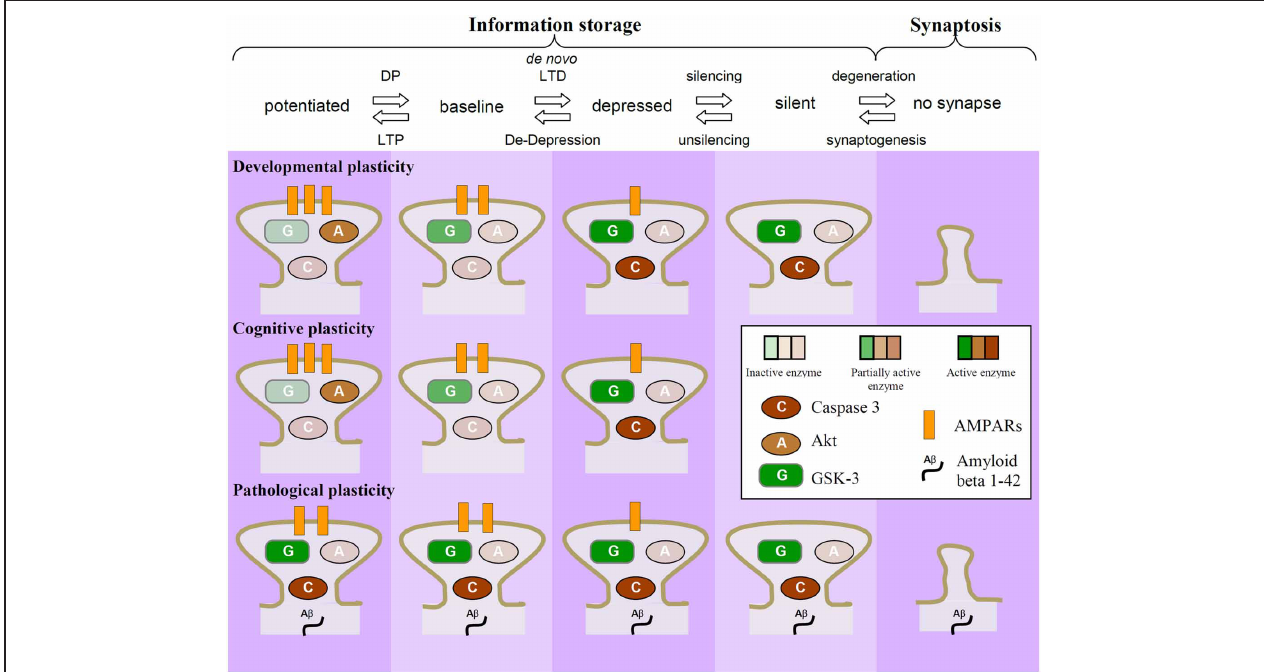
FIGURE 4 | Dysregulation of GSK-3 as a potential causal factor in neurodegeneration. NMDAR-LTD results in a reduction in the number of AMPARs at synapses. It can lead to the removal of all AMPARs (termed “silencing”) and synapse elimination, via the process of synaptosis (localized apoptosis). This process is likely to be prominent early in development, where it may be important for the pruning of unwanted synaptic connections. During adulthood it may be more tightly regulated so that LTD involves mainly